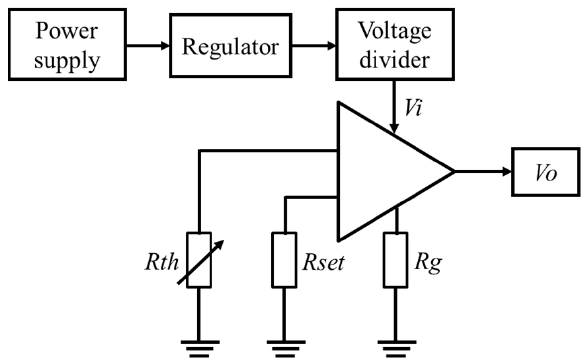
Figure 4. Schematic diagram of the temperature readout circuit.